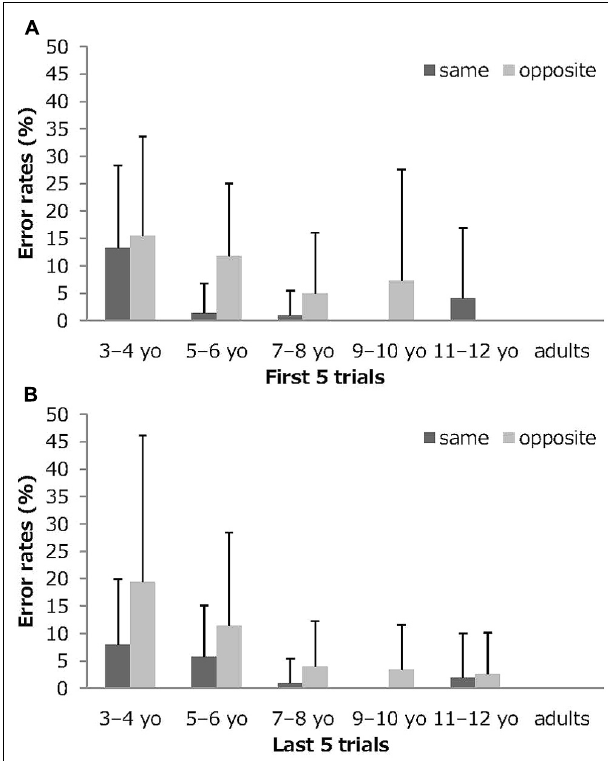
FIGURE 2 | Mean error rates early and late in the session in the Stroop-like big–small. (A) mean error rates on the first five trials, (B) mean error rates on the last five trials. Error bars represent standard deviations. On the first five trials, no error was shown for 9 to 10-year olds in the same condition, for 11 to 12-year olds in the opposite condition, and for adults in the same and opposite conditions. On the last five trials, no error was shown for 9 to 10-year olds in the same condition and for adults in the same and opposite conditions.